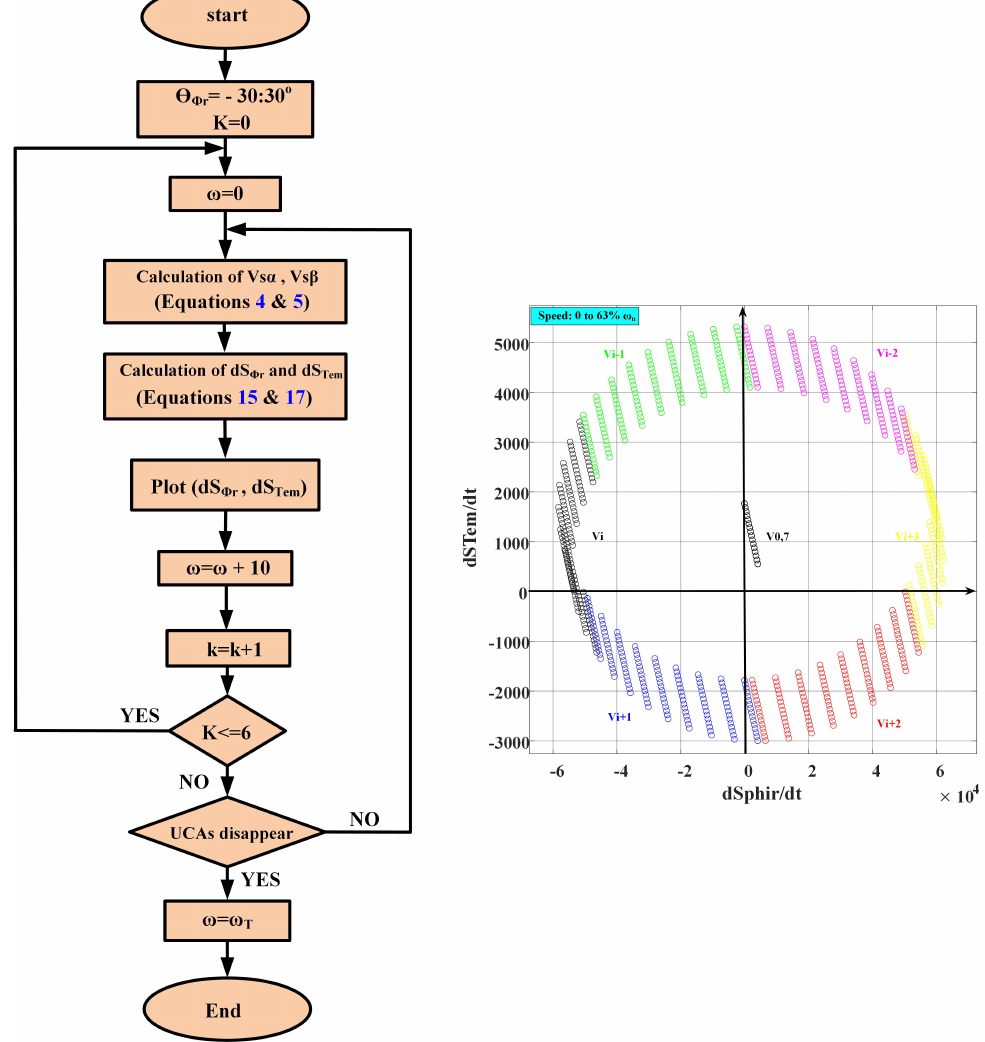
Figure 9. Change of errors of the rotor flux and torque for the range speed (0:63% ω n